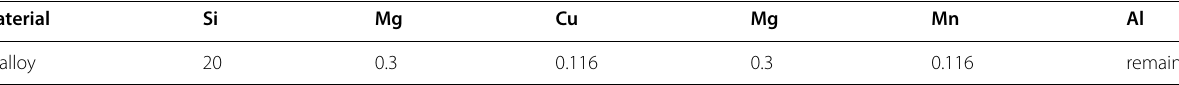
Table 3 Composition of the Aluminum alloy (mass: %) Material